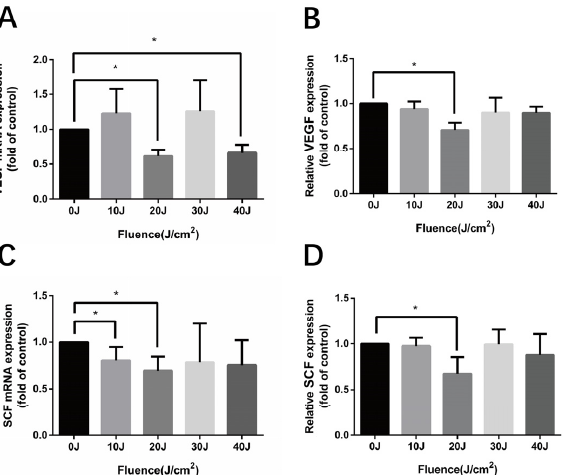
Figure 4. The expression of VEGF and SCF in HMEC-1 after 590 nm LED irradiation. ( A , B ) The synthesis and release of VEGF in HMEC-1 detected by RT-qPCR and ELISA after 590 nm LED irradiation (0–40 J/cm 2 , 24 h). ( C , D ) SCF synthesis and secretion of irradiated HMEC-1 48 h later. Data of treatment groups are normalized to the control and independent experiment results are expressed as means ± SD. ( A , B ) n = 3; ( C , D ) n = 5. *, p < 0.05. VEGF, vascular endothelial growth factor; SCF, stem cell